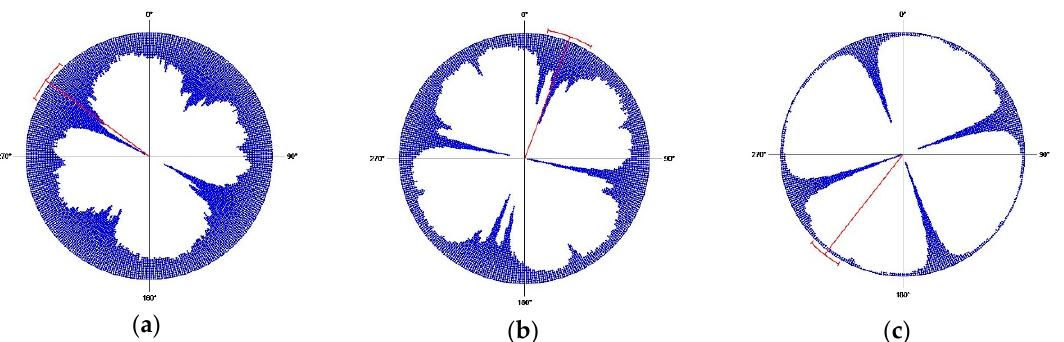
Figure 4. Raw orientation data in ( a ) zone 1, ( b ) zone 2, and ( c ) zone 3. The mean azimuth is plotted in red.